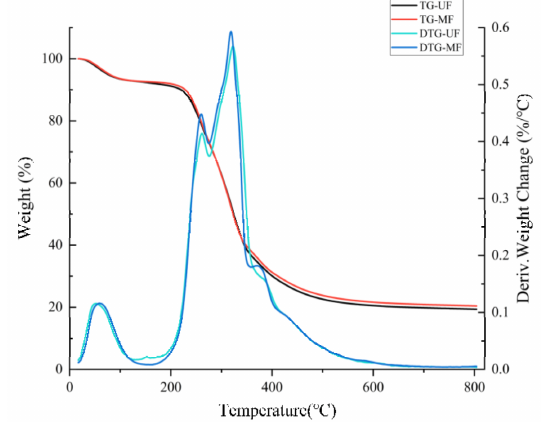
Figure 4. TGA-DSC analysis of unfermented and mixed fermented soybean residue. UF, unfermented soybean residue; MF, mixed fermented soybean